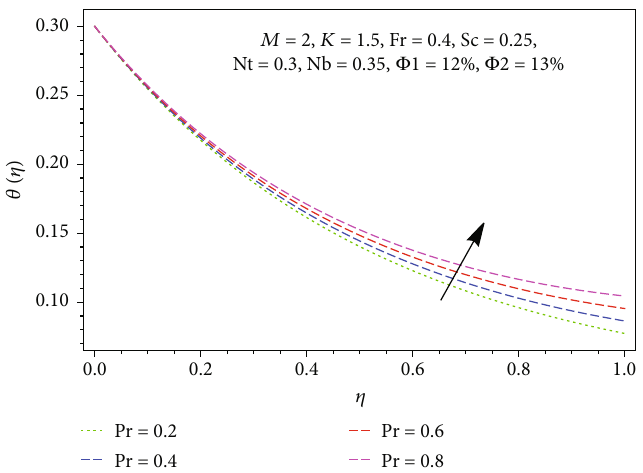
Figure 20: E ff ect of Prandtl number Pr over momentum pro fi le f ð η Þ